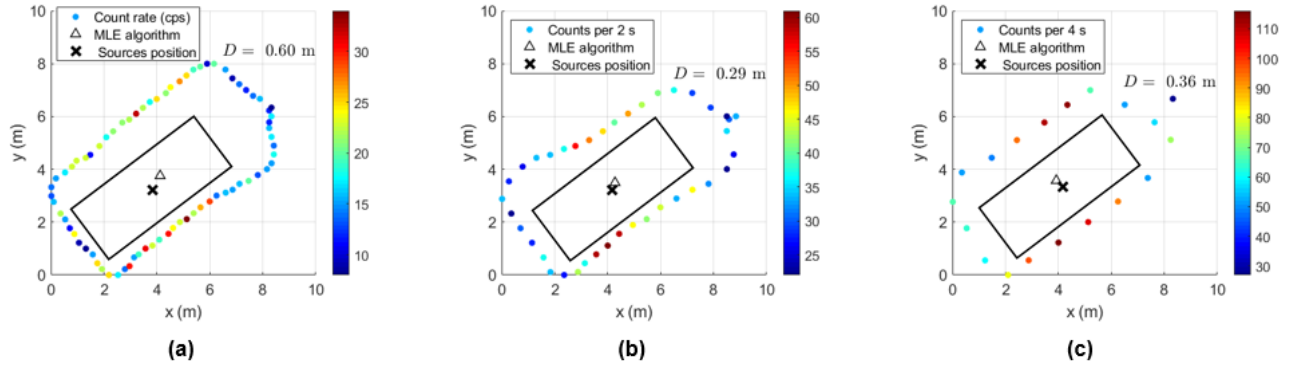
Figure 19. EJ-200 scintillator gamma-ray count rate (cps) measurements obtained using the handheld configuration of the detection system considering 137 Cs sources of 4 MBq positioned at the center of the container. The distance “D” between the real sources position and the estimated position (MLE algorithm) is also given. Detection system trajectories were performed at half of the container height.